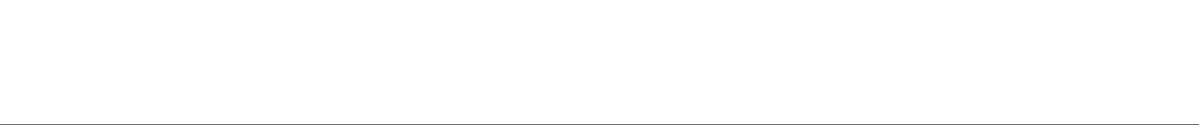
Frontiers in Astronomy and Space Sciences |